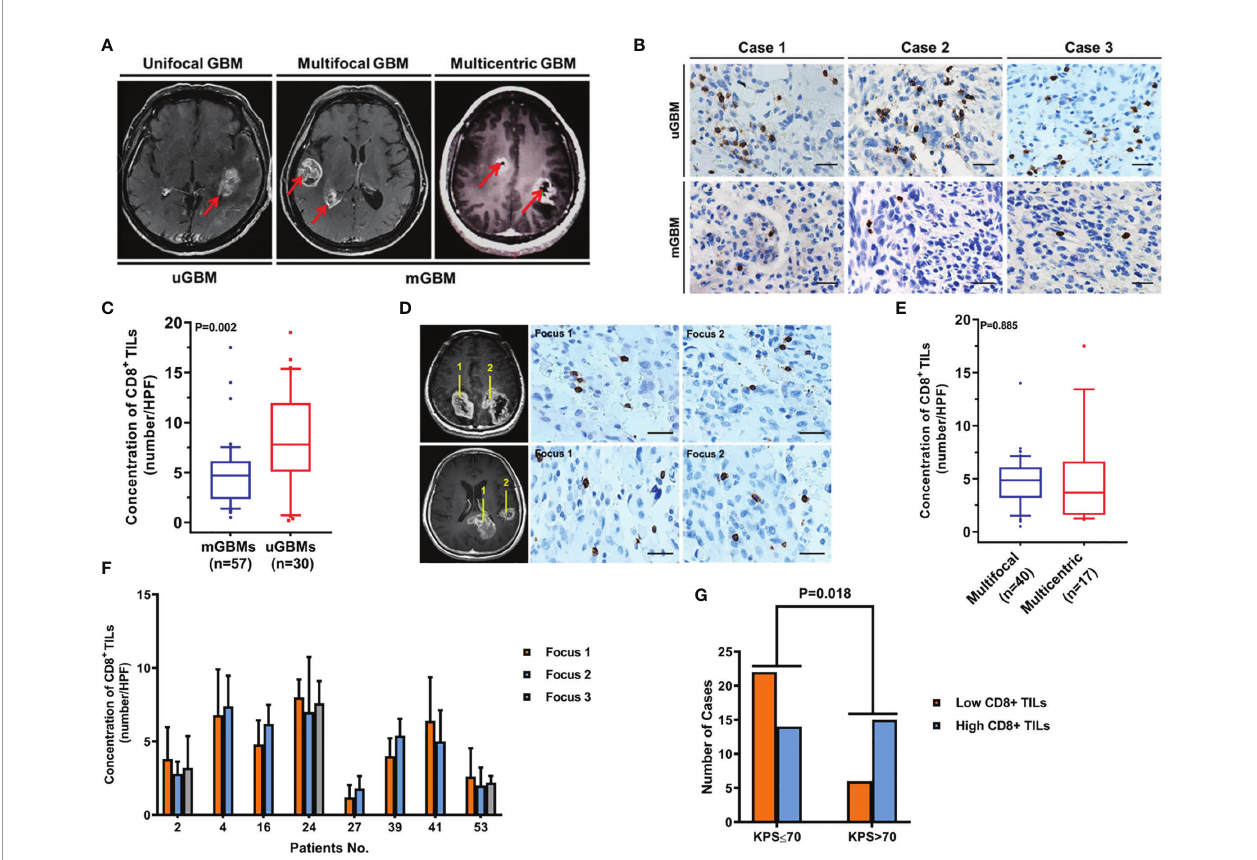
FIGURE 1 | CD8 + TIL levels are decreased in mGBMs. (A) Typical MRIs of a unifocal GBM (uGBM), multifocal GBM, and multicentric GBM (mGBM). (B) Representative CD8 + TIL IHC images of uGBM and mGBM cases. Scale bar, 20 m m. (C) The concentration of CD8 + TILs was signi fi cantly lower in mGBMs than in uGBMs. (D) IHC staining of CD8 + TILs in different foci of multicentric and multifocal GBMs. Scale bar, 20 m m. (E) The presence of CD8 + TILs was similar between multifocal and multicentric GBMs. (F) In mGBMs, no signi fi cant difference in the concentration of CD8 + TILs was observed among foci from the same patient. (G) CD8 + TIL levels were signi fi cantly correlated with preoperative